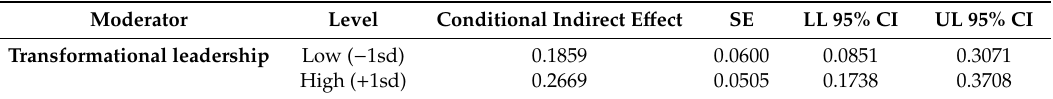
Table 4. Moderated mediation test of